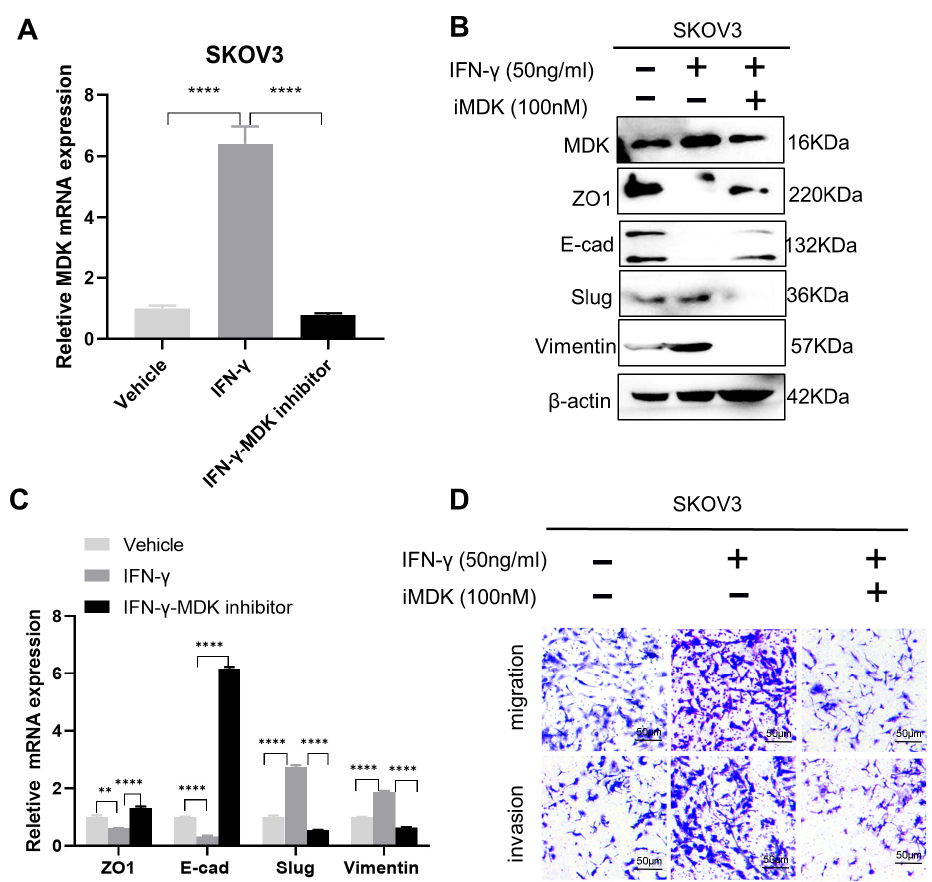
Figure 5. MDK inhibition attenuates the pro-metastatic adverse effect of IFN- γ . ( A ) Real-time qPCR to examine the effect of iMDK on IFN- γ -induced MDK expression at the mRNA level in SKOV3 cells. ( B ) Western blotting assays to detect the effect of iMDK on IFN- γ -induced MDK and EMT markers expression at the protein level in SKOV3 cells. ( C ) Real-time qPCR assays to validate the role of iMDK in suppressing IFN- γ -induced EMT activation in SKOV3 cells. ( D ) Transwell assays to determine the effect of iMDK on IFN- γ -induced migration and invasion in SKOV3 cells. Data are represented as mean ± SD. ** p < 0.01, **** p < 0.0001.